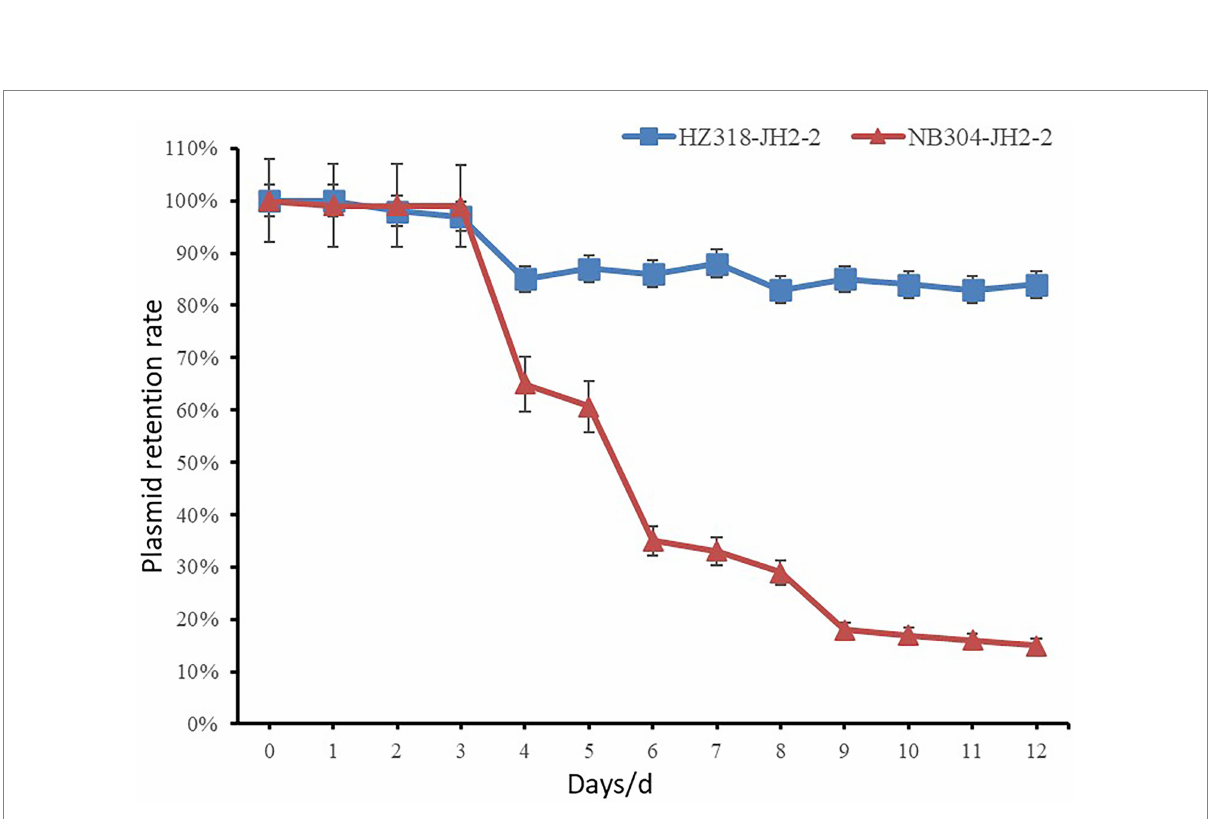
FIGURE 9 Stability of the plasmids in